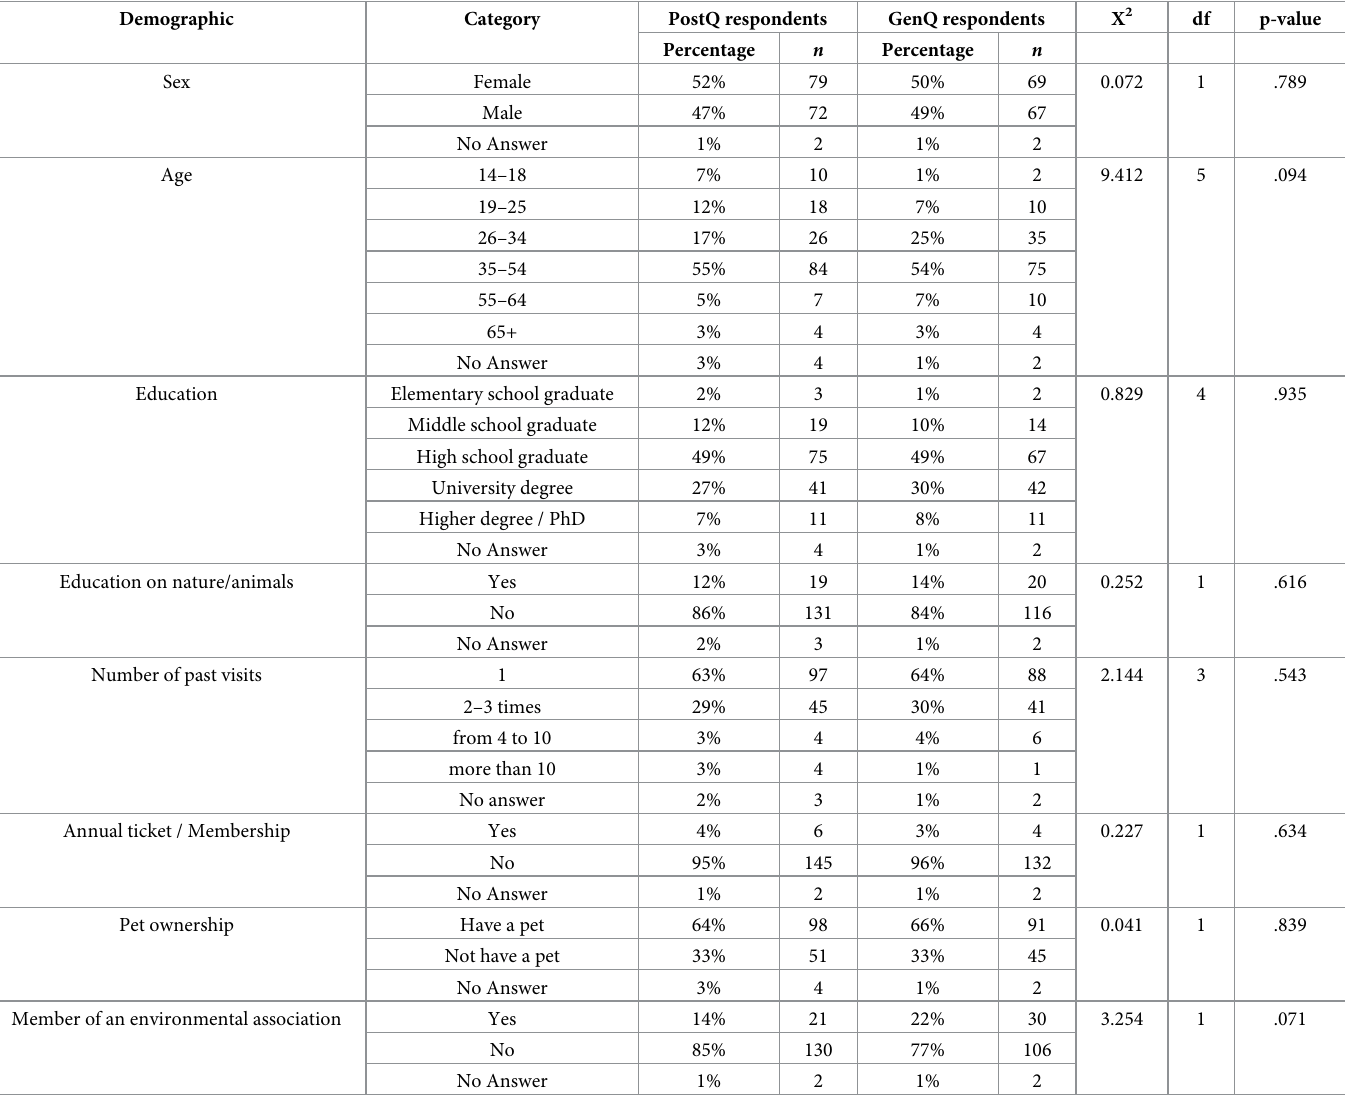
Table 4. Demographical information for PostQ and GenQ